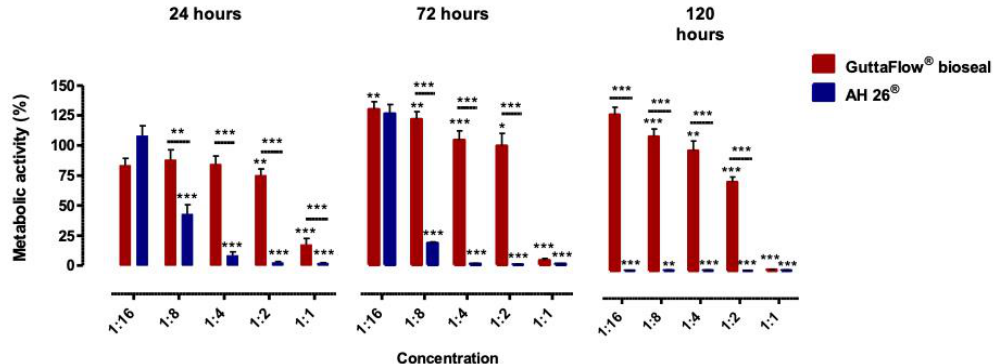
Figure 1. Metabolic activity of the MDPC-23 cell cultures after 24, 72, and 120 h of incubation with the biomaterials conditioned media. The results are presented as the mean and standard error of a minimum of six independent assays. Statistically significant differences to the control or between conditions are represented by a *, where * means p < 0.05, ** means p < 0.01, and *** means p < 0.001. Detailing the results obtained, after 24 h incubation with GuttaFlow bioseal, a significant decrease in metabolic activity to 75.03 ± 5.47% ( p = 0.006) and 17.36 ± 5.33% ( p < 0.001) at concentrations 1:2